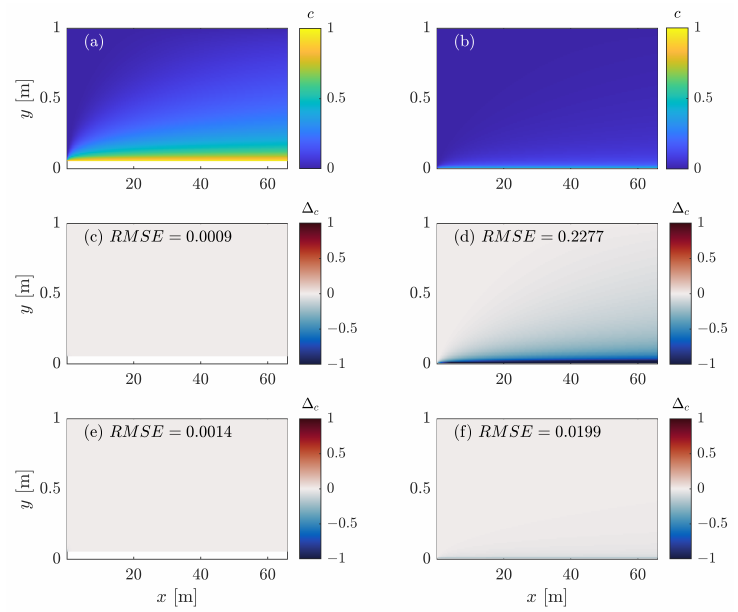
Figure 4. Comparison of the numerical and analytical solutions of channel flow as described by Hjelm- felt and Lenau [50]. Panels ( a , b ) show the analytical solution for Pe = 0.1 and Pe = 5 respectively. Panels ( c – f ) show the difference ∆ c between the analytical solution c and the numerical solution c num . Panels ( c , d ) show the old scheme for both Peclet numbers, and panels ( e , f ) show the new scheme for both Peclet numbers.